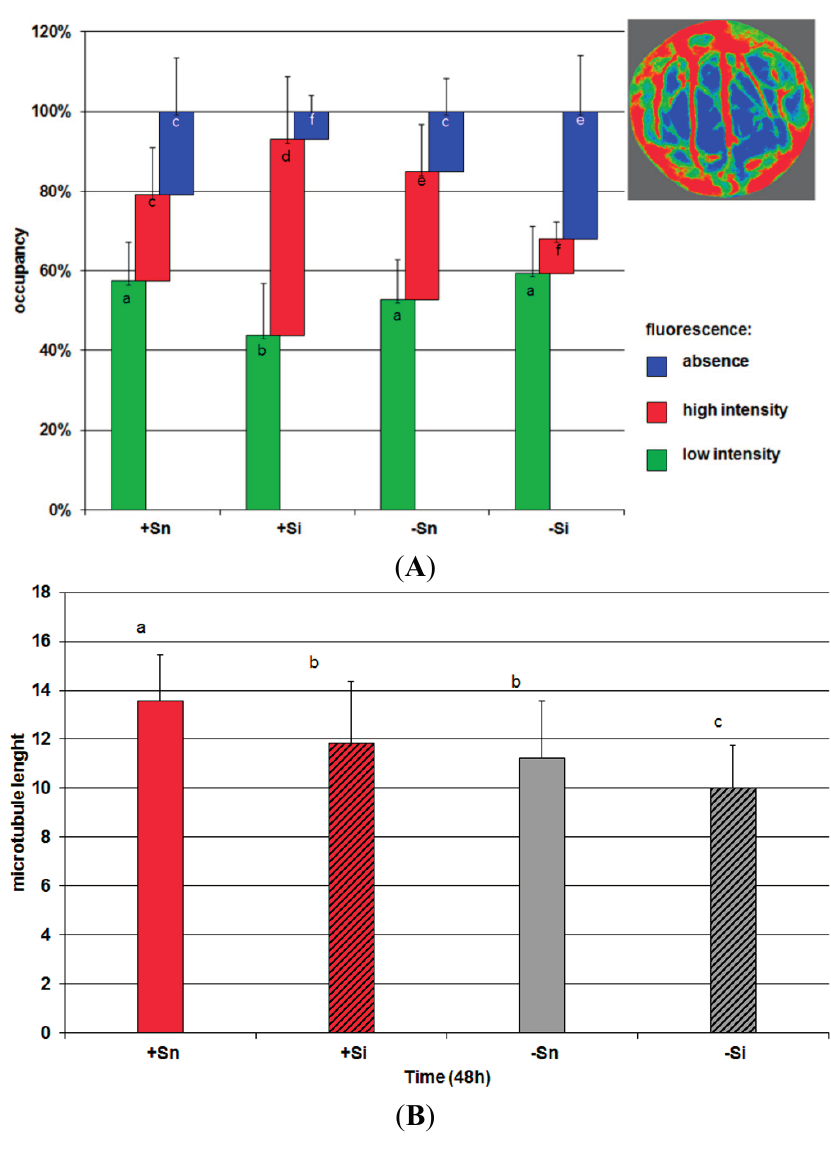
Figure 8. ( A ) The effect of sucrose and F. oxysporum on actin cytoskeleton density in cells of embryo axes of L. luteus . To estimate the density of microfilaments (MFs), the occupancy (%) of the pixel areas of AlexaFluor signals from segmented images (example image in legend) of cell was calculated. The red color represents areas of high fluorescence intensity corresponded to actin cables, green color-areas of low fluorescence corresponding i.e. , to remaining places containing actin and blue color-regions of cells without fluorescence signal. Different small letters (a,b,c,d,f) denote statistically significant differences ( p < 0.05); ( B ) Mean length of microtubules bundles (MTs) in pixels expressed by the parameter of fiber length; ( C ) Mean width of microtubules bundles (MTs) in pixels expressed by the parameter of fiber